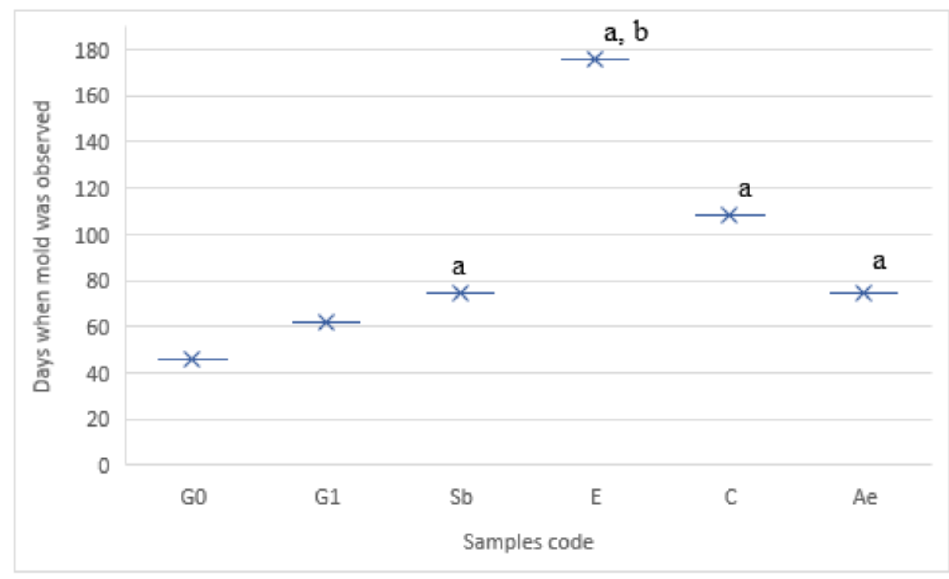
Figure 5. Chewable gel tablets shelf-life in a closed plastic box at room temperature (CR). a— p < 0.05 vs. G1; b— p < 0.05 vs. C; n = 8; * study duration was 180 days; Ee, Eo, and Eos did not have a mold after 180 days, these samples are not presented in this